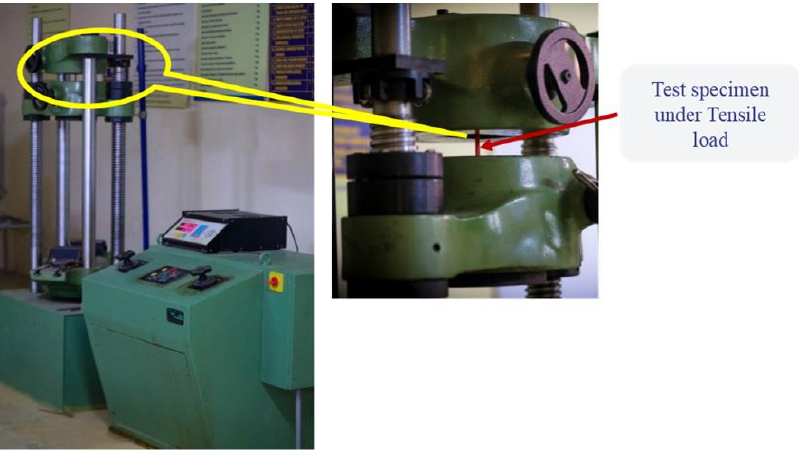
Figure 4. Universal testing machine with